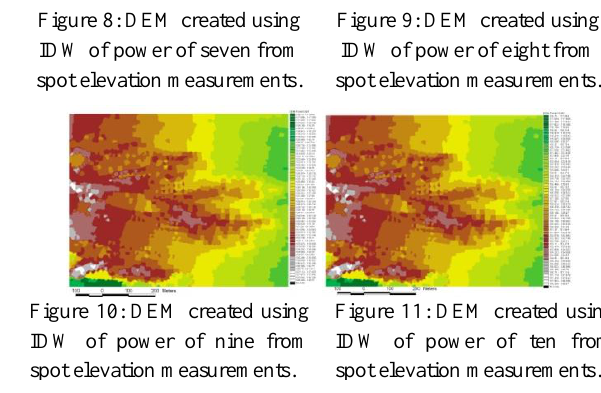
Figure 10: DEM created using IDW of power of nine from spot elevation measurements.